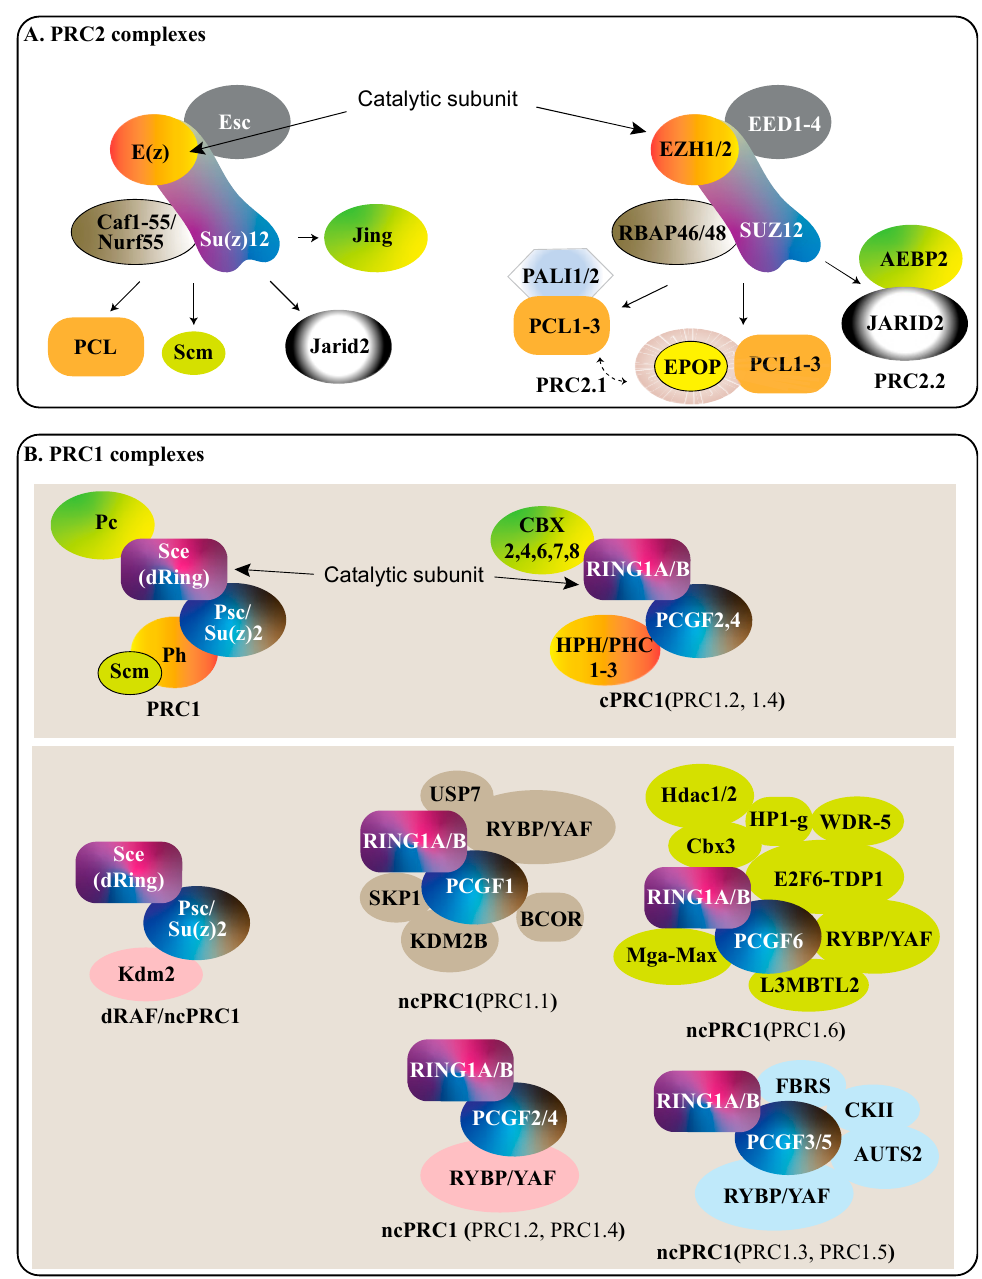
Figure 1. A comparison of Drosophila and mammalian Polycomb complexes. ( A ) PRC2 in Drosophila (left) and mammals (right). The main subunits of PRC2 are conserved between Drosophila and mammals with differences in interacting components. The core-conserved subunits are color coded. ( B ) PRC1 in Drosophila (left) and mammals (right). Canonical (cPRC1) and various forms of non-canonical (ncPRC1) mammalian PRC1 are depicted. Drosophila PRC1 and mammalian cPRC1 exhibit many conserved subunits; conserved subunits are color coded. The various forms of mammalian ncPRC1 share only RING1A/B and one PCGF member in common with cPRC1. Adapted from Kuroda et al. [28].